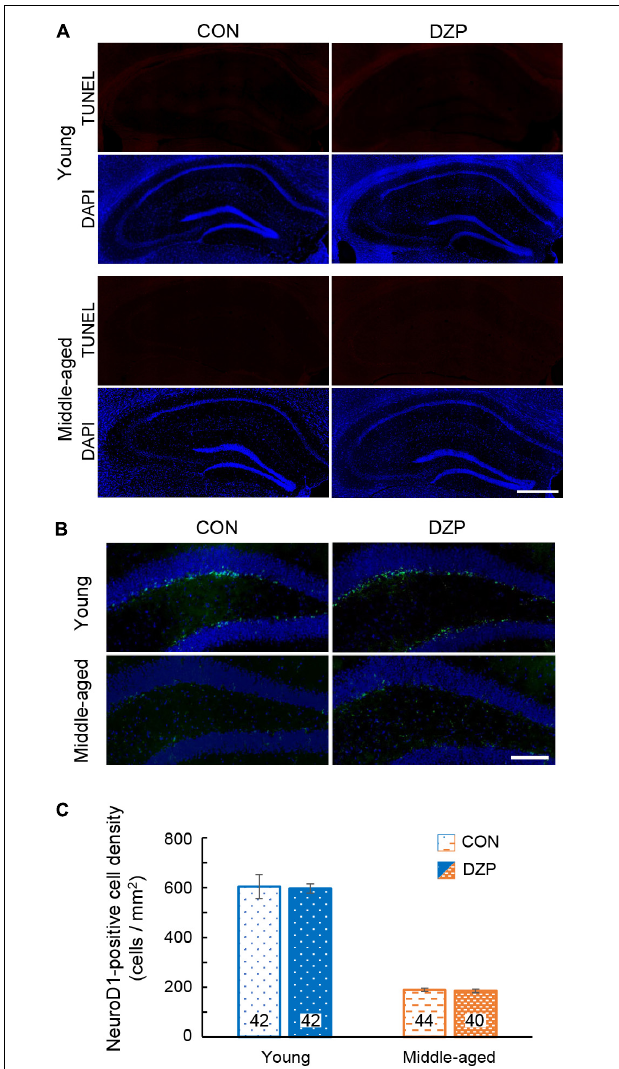
FIGURE 2 | Effects of chronic diazepam administration on apoptosis and neurogenesis in the hippocampus. (A) Fluorescence microscopic image of TUNEL (red) and DAPI (blue) staining. Scale bar, 500 µ m. (B) Immunofluorescence image of NeuroD1 (green) and DAPI (blue) staining in the hippocampus of young and middle-aged mice. Scale bar, 50 µ m. (C) Density of NeuroD1-positive cells in the dentate gyrus. The number in bar graph indicate the number of sections ( N = 5 animal, 7–9 sections/animal). Error bar: mean ± SEM. CON, control group; DAPI, 4 (cid:48) ,6-diamidino-2-phenylindole; DZP, diazepam group; NeuroD1, neurogenic differentiation factor 1; TUNEL, terminal deoxynucleotidyl transferase dUTP nick end